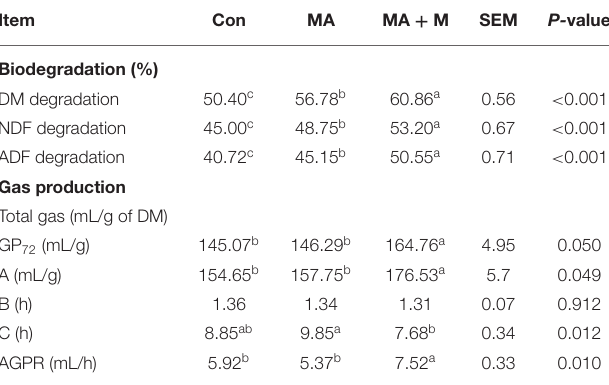
( Figure 9 ). The relative abundance of